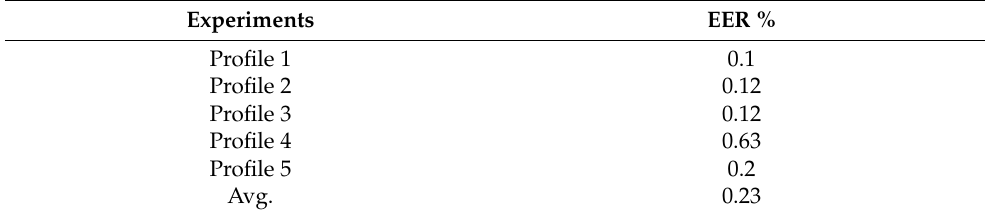
Table 16. Authentication ERR of VGG-19-F7 deep features after applying PCA